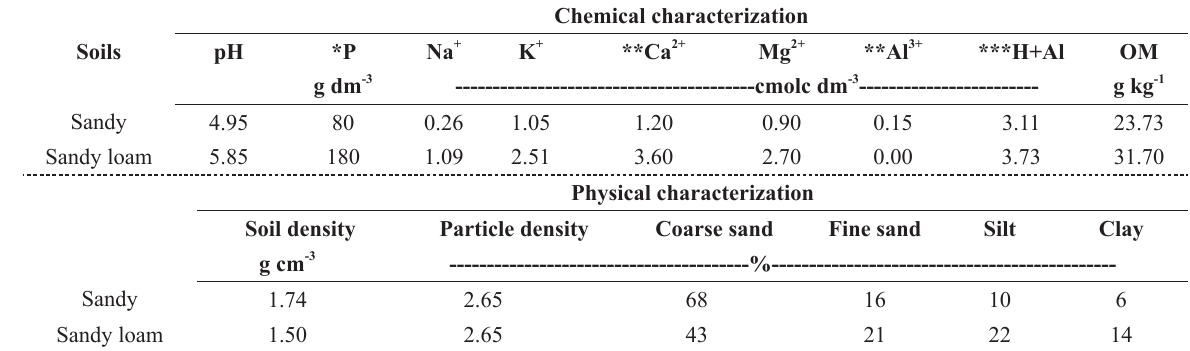
Chemical and physical characterization of the soils used in the experiment. Chemical Soils